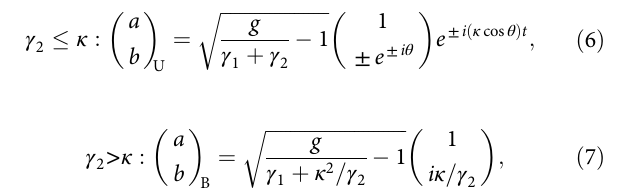
p ffiffiffiffiffiffiffiffiffiffiffiffiffiffiffi κ 2 (cid:3) g 2